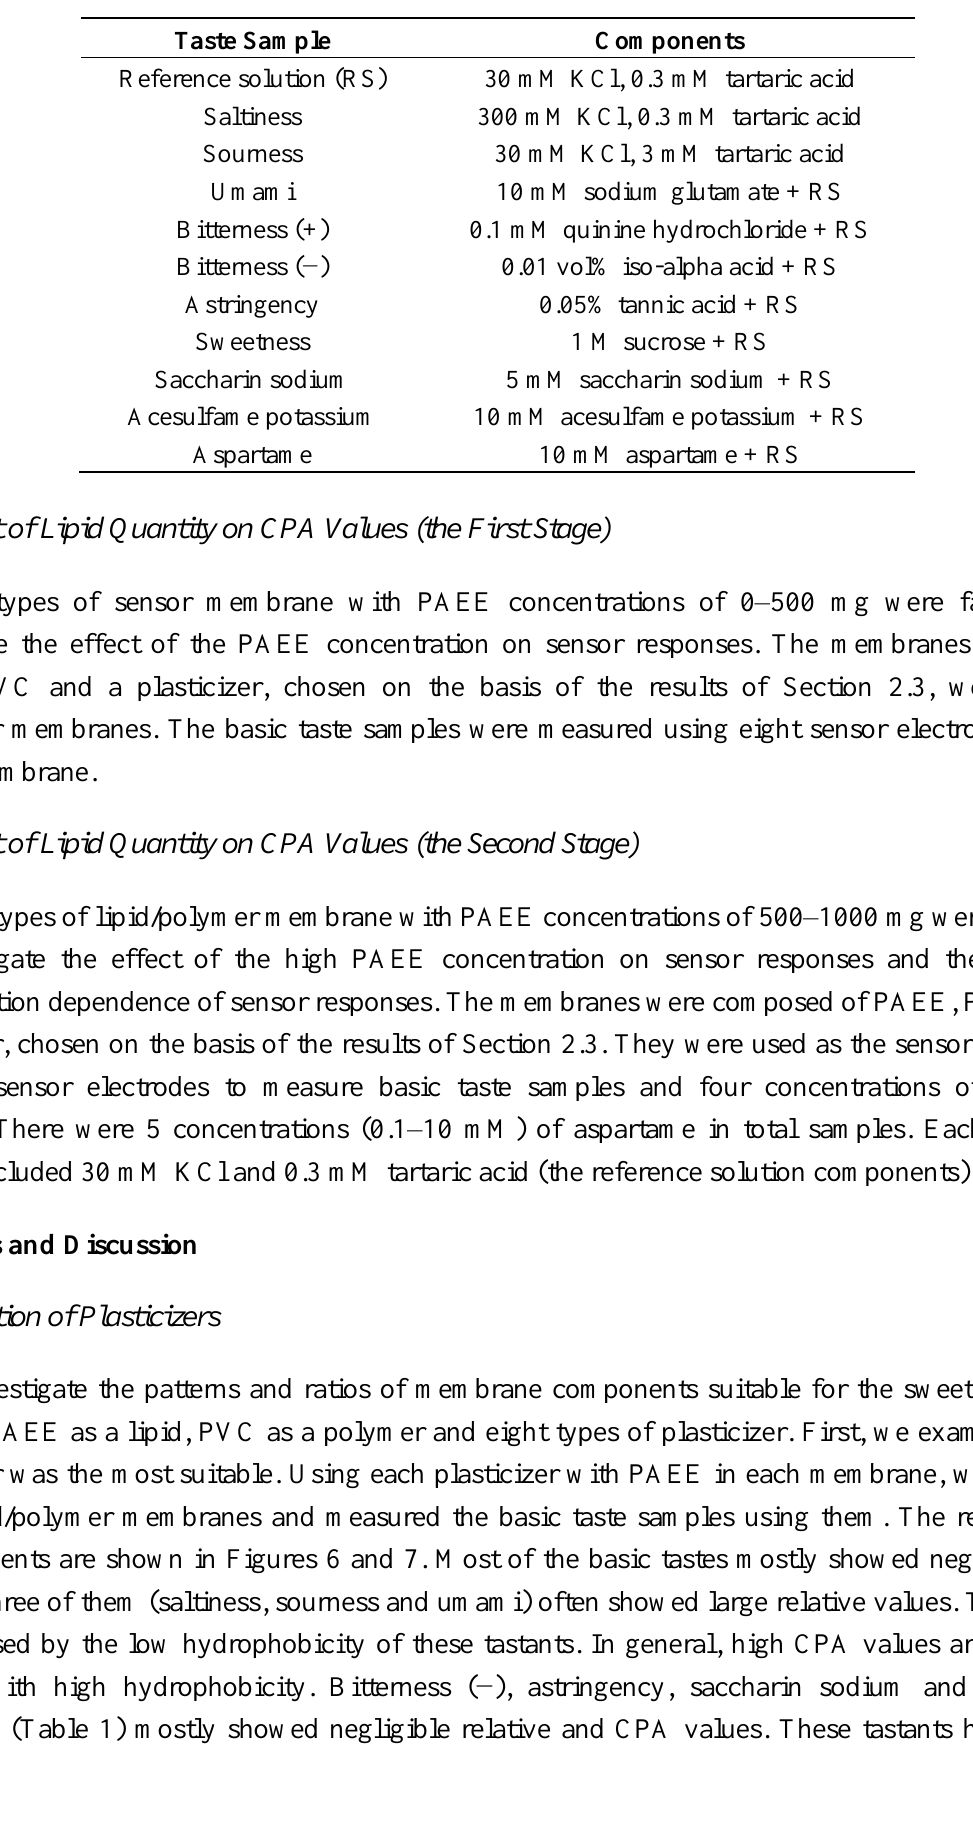
Table 1. Basic taste